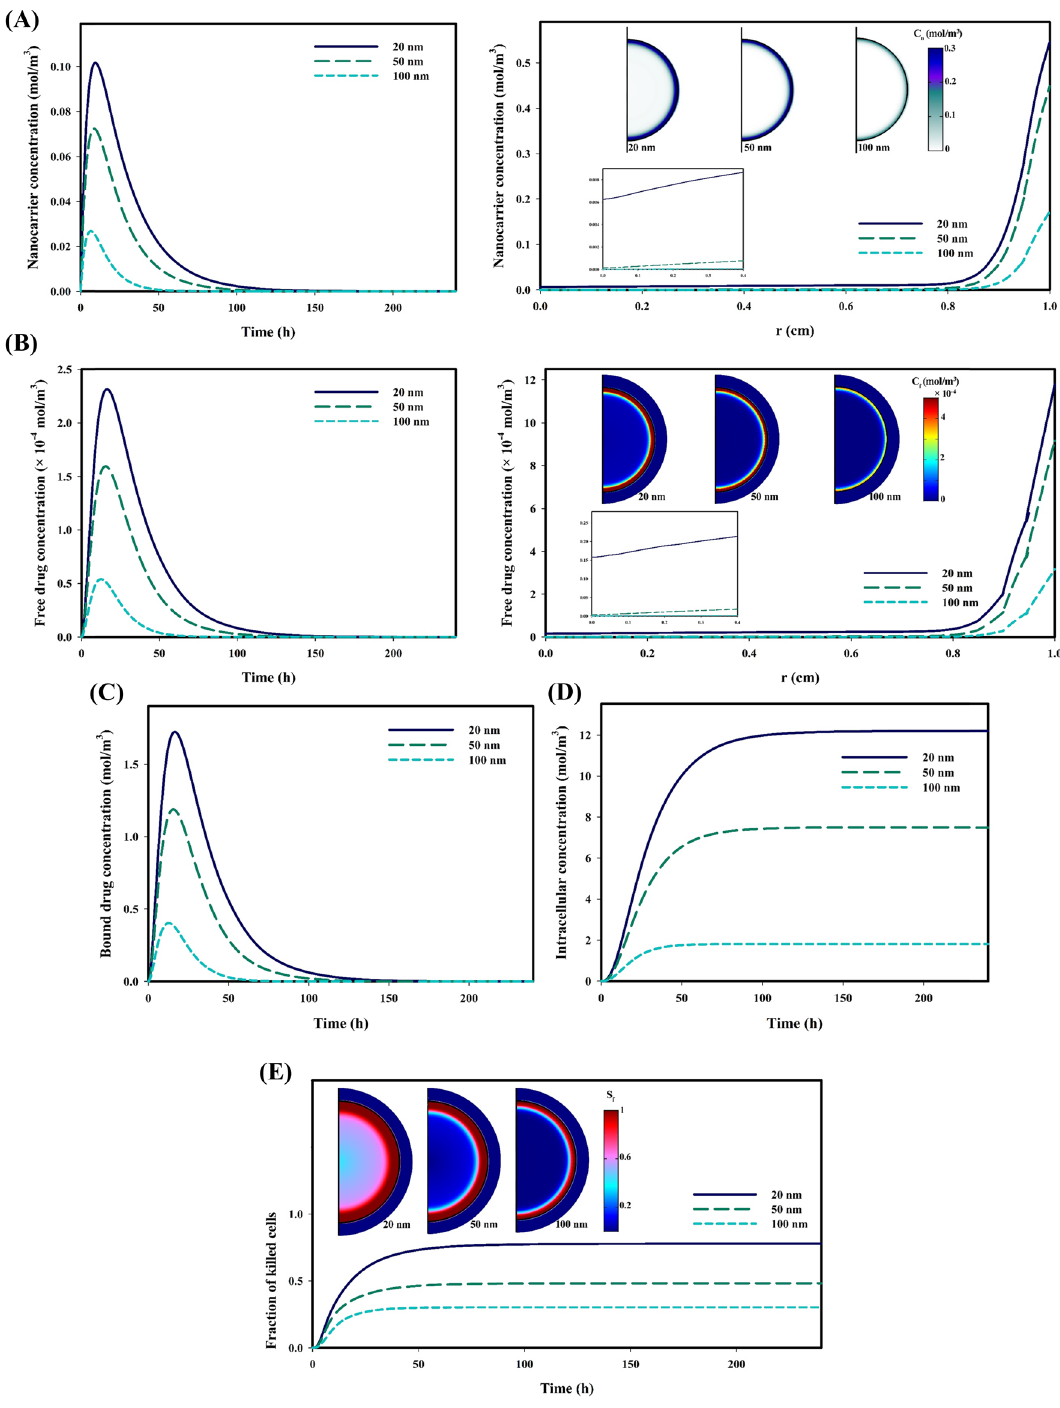
Figure 3. Distribution of therapeutic agents and therapeutic response in a vascularized tumor for three different sizes of pH-responsive nanocarriers; ( A ) Spatiotemporal distribution distribution of responsive nanocarriers in tumor interstitium; Smaller nanocarriers have more accumulation in tumor tissue and also have a higher penetration depth, ( B ) Spatiotemporal distribution distribution of free drug in tumor interstitium; The concentration of released free drugs from smaller nanocarriers is greater due to the high accumulation of smaller nanocarriers compared to their larger counterparts, ( C ) Temporal distribution of bound drug in tumor interstitium; High accumulation of drugs released from 20 nm nanocarriers increases the chance of free drug molecules binding to cell surface receptors, ( D ) Temporal distribution of internalized drug in cellular; Binding of high concentrations of free drug molecules to cell surface receptors results in higher concentrations of internalized drug, ( E ) Fraction of killed tumor cells over time; High concentration of internalized drugs increase the fraction of killed cells. Also, due to the accumulation of free drug in the periphery of the tumor, the cells in this region have suffered the most damage. ( C n : Nanocarrier concentrations , C f : Free drug concentrations , S f : Fraction of killed